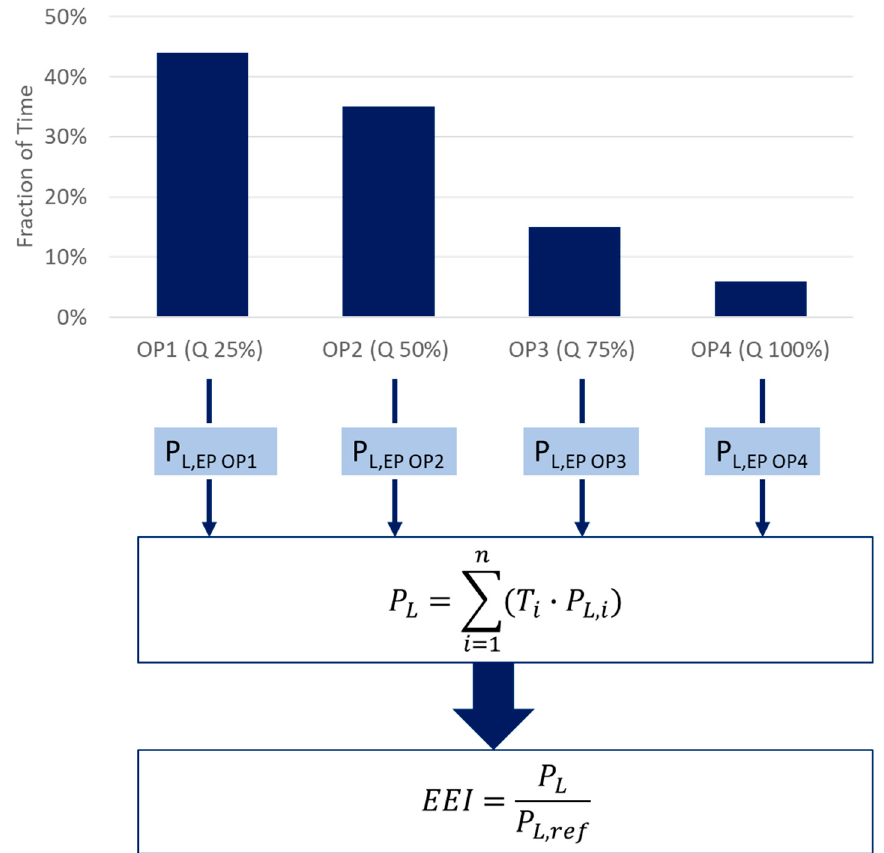
Figure 6. Example of application of the Extended Product Approach in typical load profiles of pumps used in heating, ventilation and air conditioning (HVAC) systems.